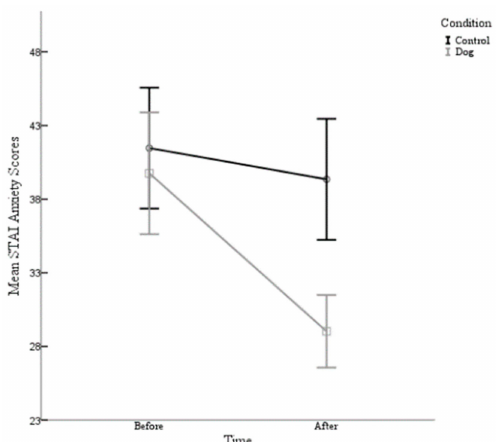
Figure 1. The mean State-Trait Anxiety Inventory (STAI) anxiety scores are plotted for the participants in the control condition and the participants in the experimental (dog) condition before their interaction and after their interaction with 95%-confidence-interval error bars.